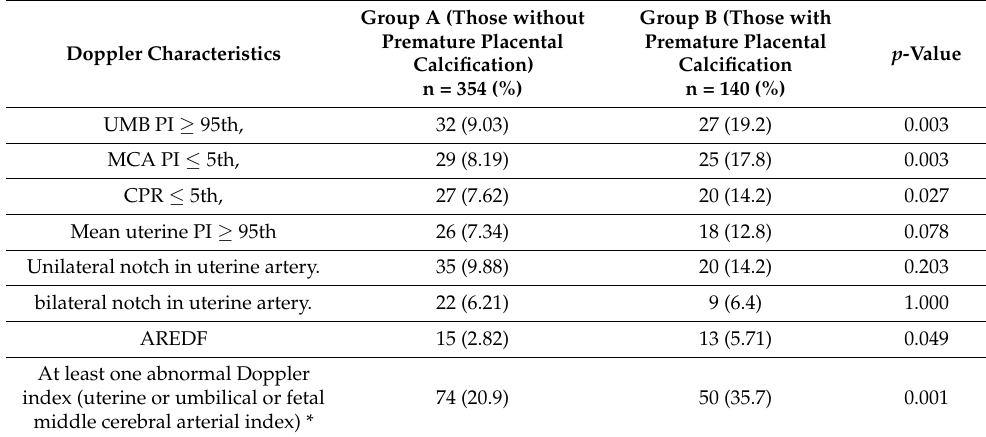
Table 4. Comparison of Doppler abnormalities between the two groups.